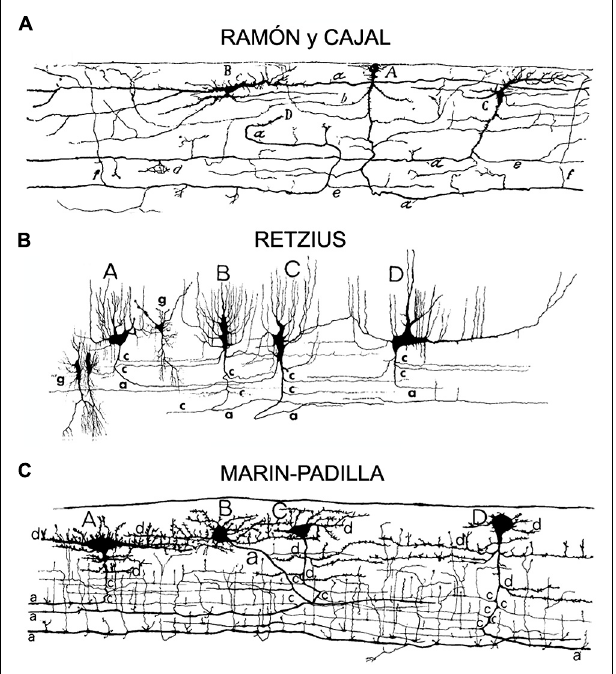
FIGURE 1 |Adapted from Marin-Padilla (1990). Original drawings of Cajal–Retzius cells from the motor cortex of a (A) 2-month-old infant (Ramon y Cajal, 1911), (B) a 26-week-old fetus (Retzius, 1894), (C) a newborn (Marin-Padilla and Marin-Padilla, 1982), sagittal perspective of layer I. Pyriform or triangular (Cajal A; Retzius A,B,C; Marin-Padilla C,D), horizontal monopolar or bipolar (Cajal B; Retzius D; Marin-Padilla A), and stellate like (Marin-Padilla B) cell